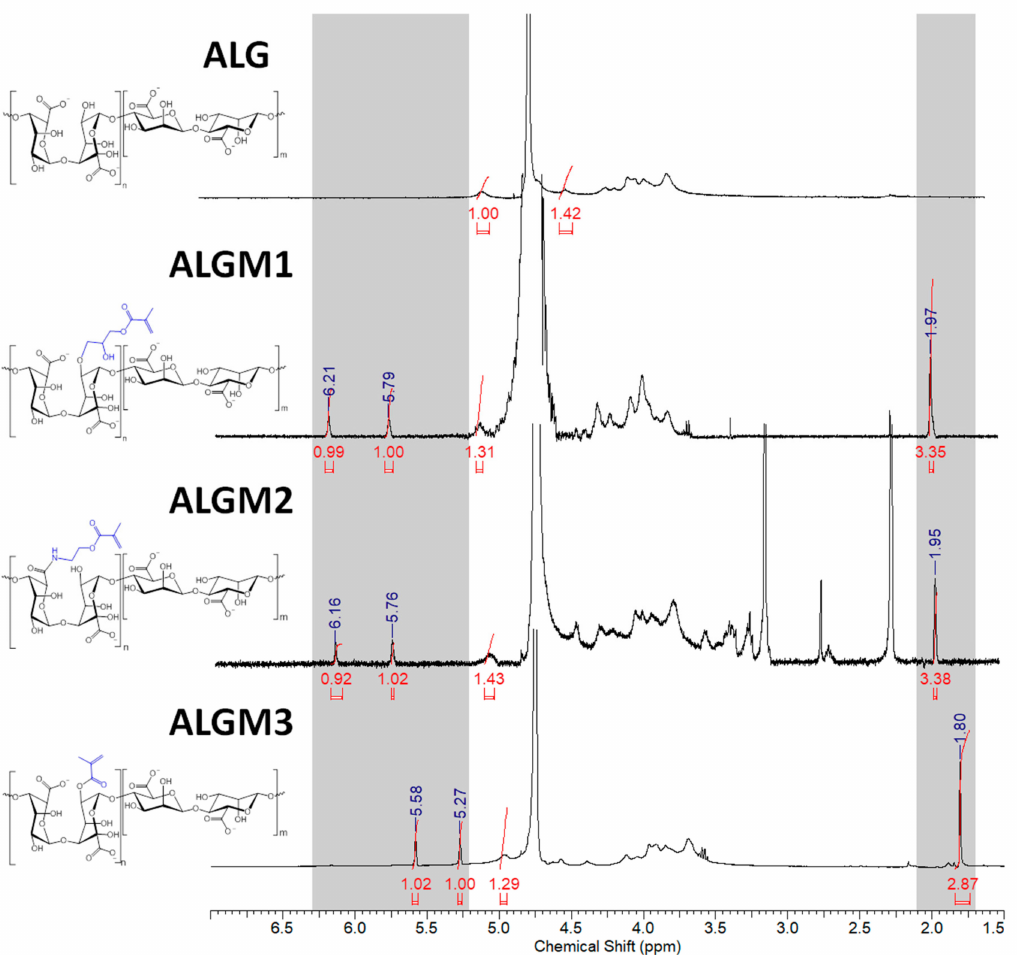
Figure 3. 1 H-NMR spectra of ALG and ALGMx macromers. The grey zones mark the chemical shift ranges of the vinyl (5.20–6.30 ppm) and methyl hydrogens (1.70–2.10 ppm) of the grafted Mx groups. D 2 0 was used as a solvent in all